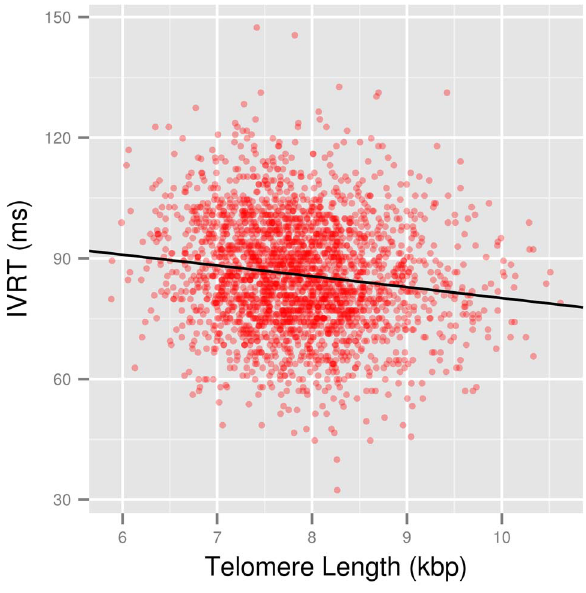
Fig. 2. TL , IVRT. Scatterplot showing the unadjusted correlation between telomere length (TL) and isovolumic relaxation time (IVRT) (red) and the regression line (black).